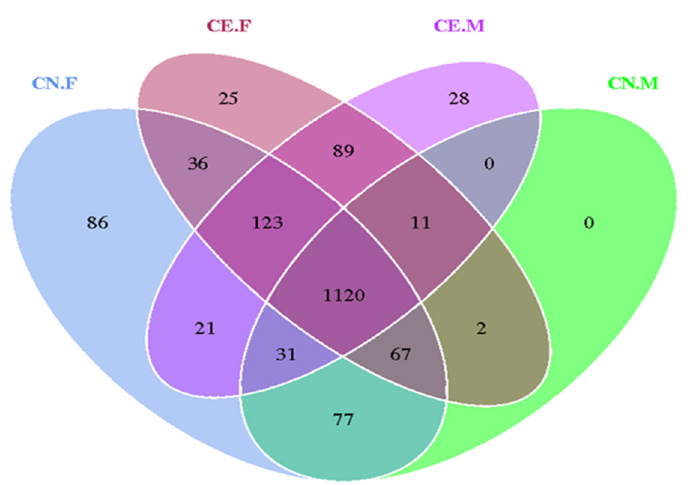
Figure 5. Venn graph of the OTU clustering. Venn graph shows the common and unique OTUs among the different groups. The overlapping regions indicate the number of shared